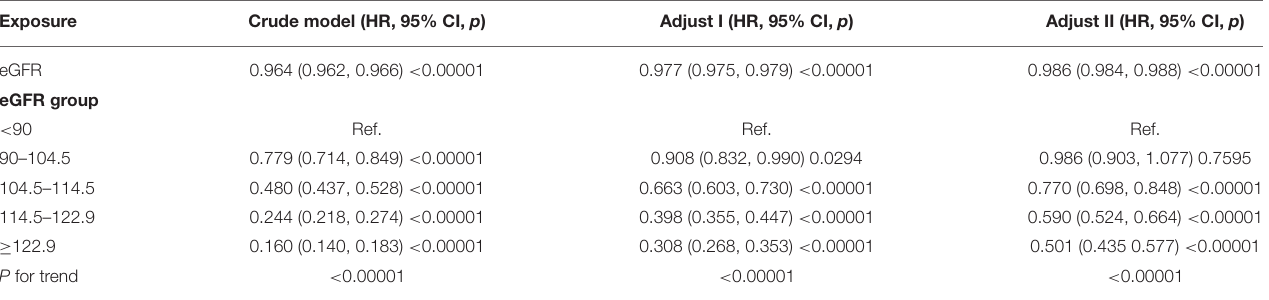
TABLE 4 | Relationship between eGFR and the incident diabetes in different models.